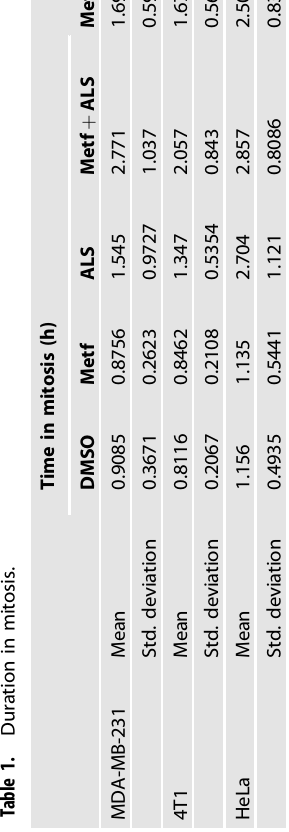
Cell cycle analysis Cell cycle stages of PercevalHR expressing cells were determined by 7-AAD staining and fl ow cytometry. Harvested cells were adjusted to 1 × 10 6 cells/ mL and washed in cold PBS. Cells were resuspended and fi xed in cold 70% CytoFLEX Platform (Beckman Coulter) was used to detect DNA content. The p-HH3 (Phospho Histone H3 (S10)), (Abcam, ab5176) antibody was used to determine the cell cycle state after cell synchronization and release. Cyclin B1 (Proteintech, 55004-1-AP), protein level, and aurora kinases and polo-like kinase 1 phosphorylation statue were also detected by western blot p-AKA/B/C (Phospho-Aurora A (Thr288)/Aurora B (Thr232)/